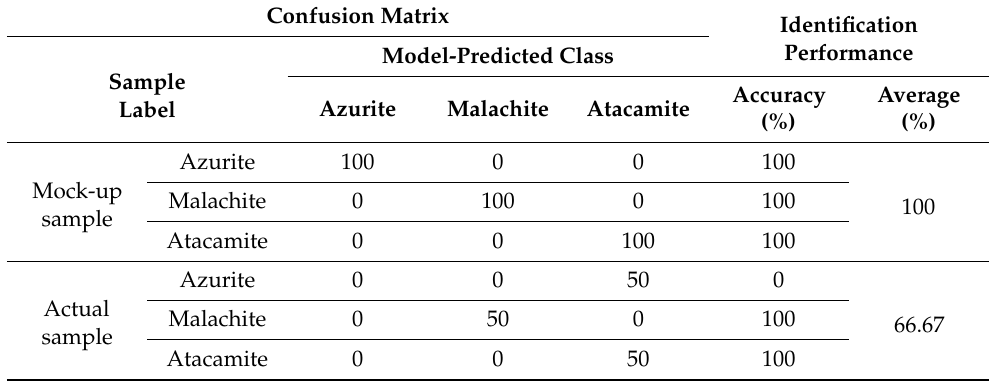
Table 2. Confusion matrix and accuracy of SVM identification model for three